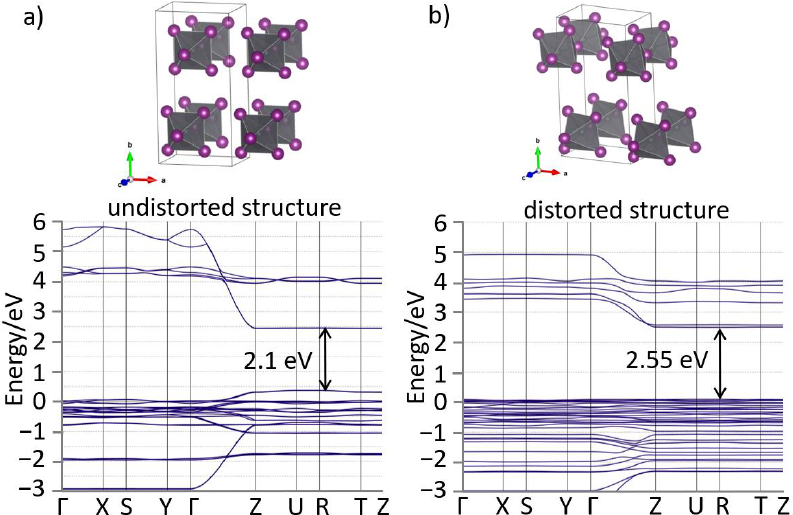
Figure 4. Calculated band structure for hypothetical undistorted ( a ) and distorted ( b ) structures of 1D perovskite-derived structures with [PbI 5 ] 3− chains.